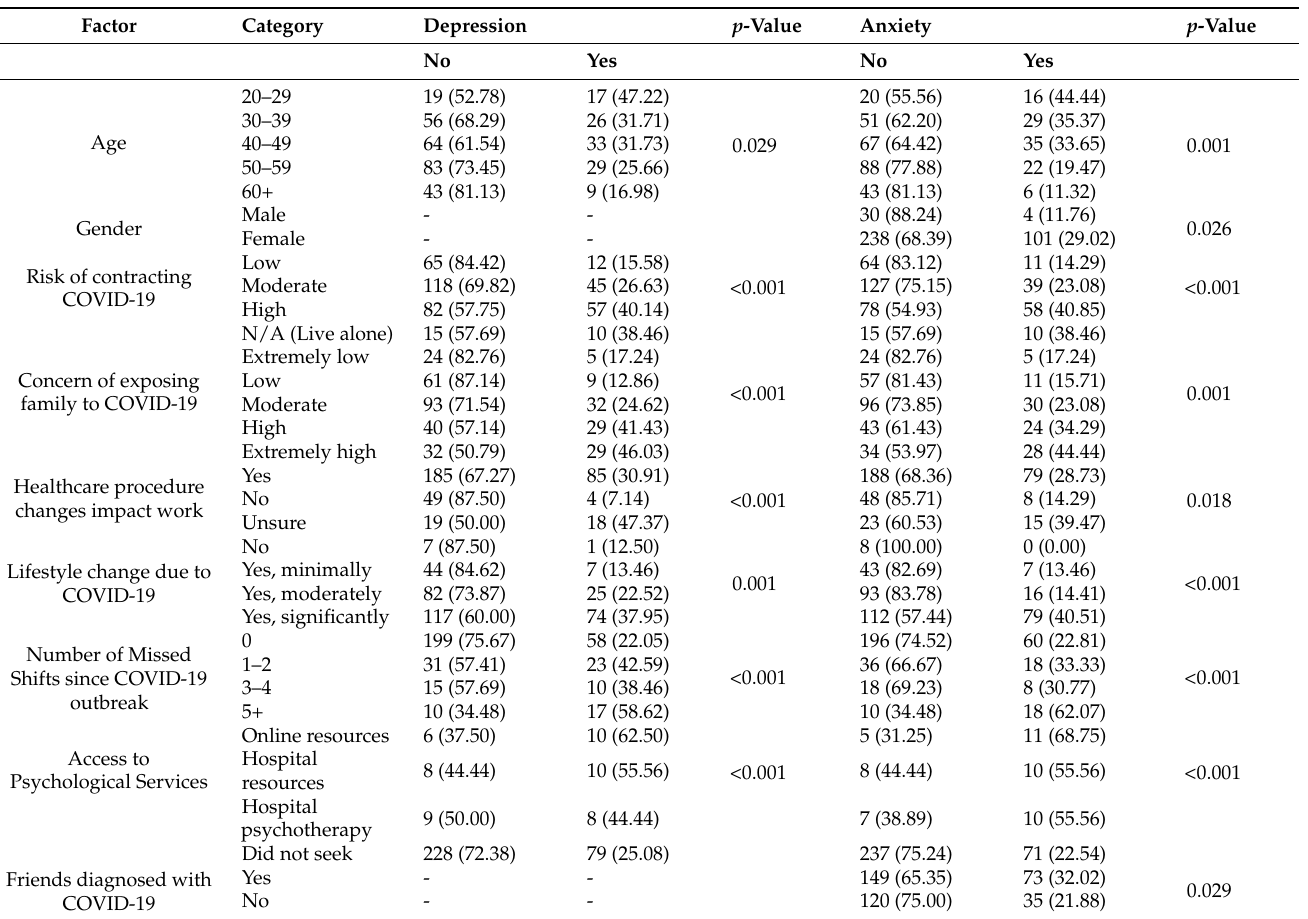
Table 4. Chi-Square associate of risk factors (number/percentage %).